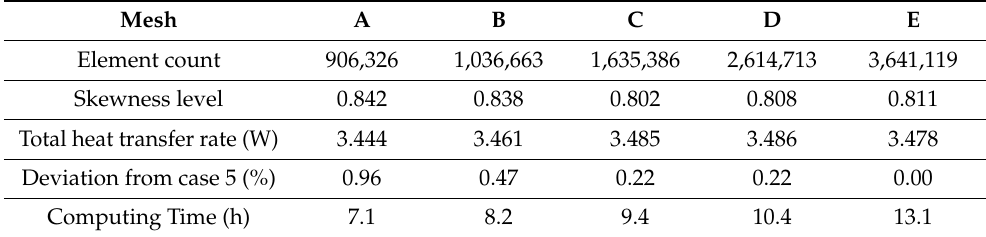
Table 1. Mesh independence test for different numbers of